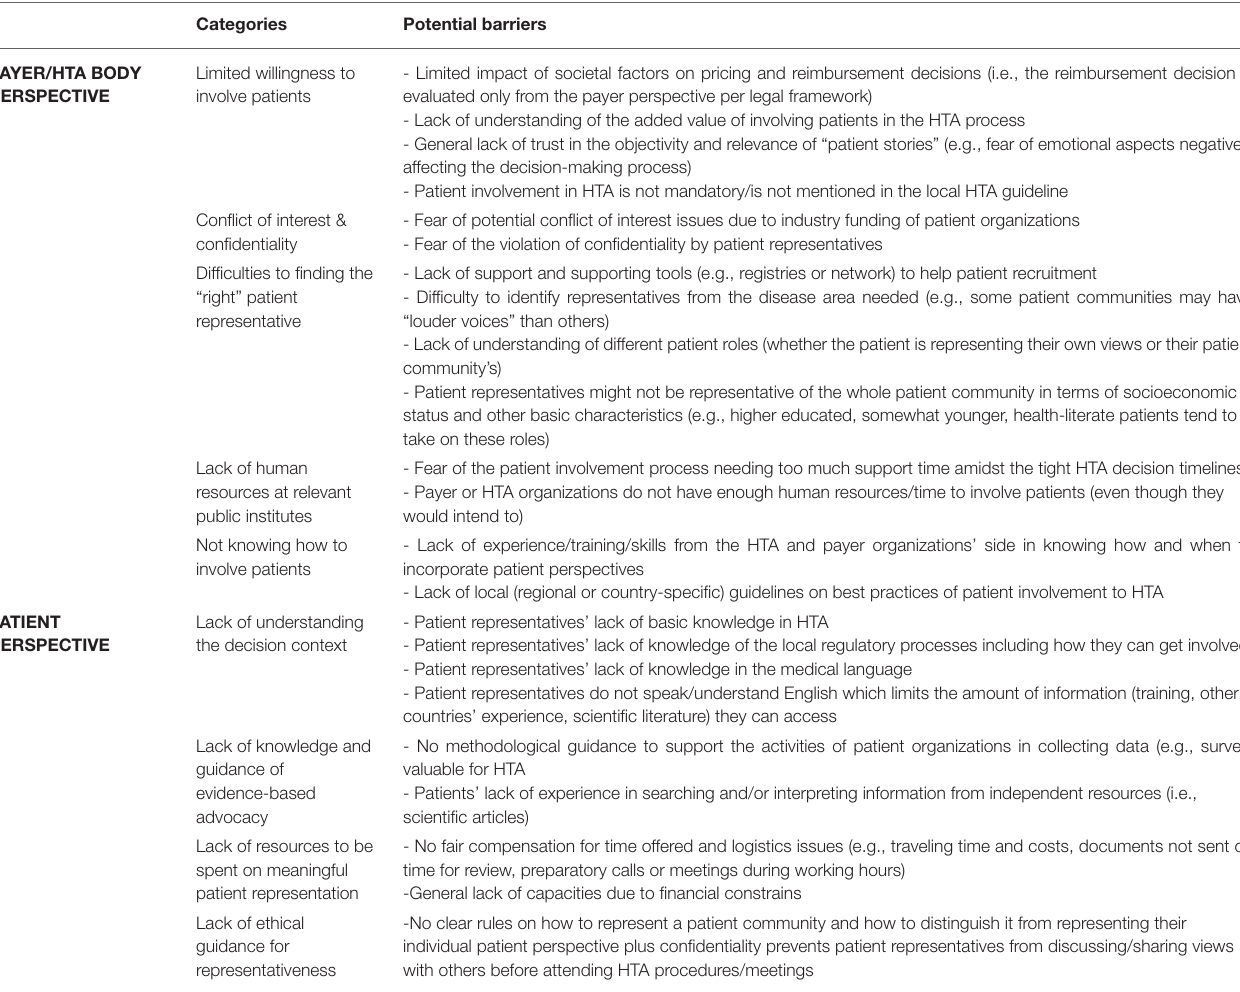
TABLE 2 | Potential barriers of patient involvement in HTA in CEE countries.